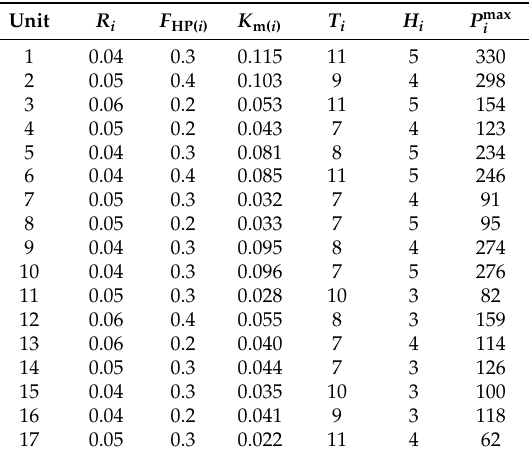
Table A3. Characteristics of Generators for the 17-unit System ( i = 1~17).